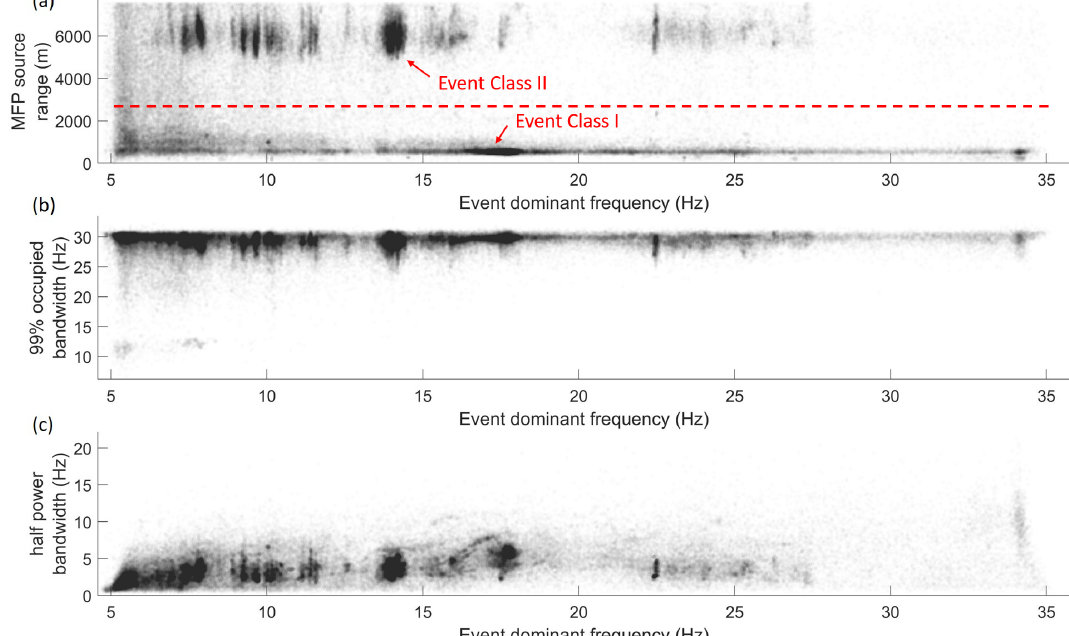
Figure C1. Illustration of the relationship between the dominant frequency estimated by Thomson’s multitaper spectral amplitude peak (Hanssen, 1997) and the (a) MFP estimated range to source, (b) bandwidth containing 99% of signal power estimated from the periodogram power spectral density, and (c) half-power bandwidth determined as the frequency range where power spectral density is within 3dB of the maximum. The two event classes are most readily identified by the range to source, as annotated by the red dashed